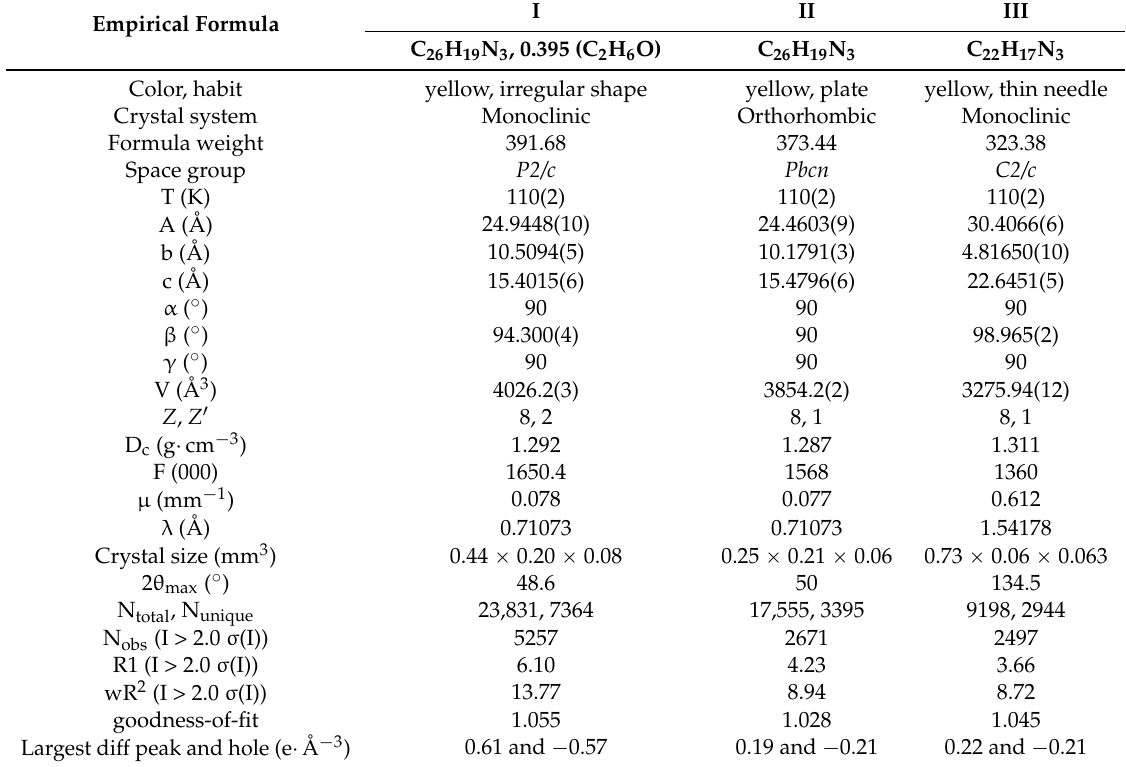
Table 1. Summary of Crystallography Data for I – III .